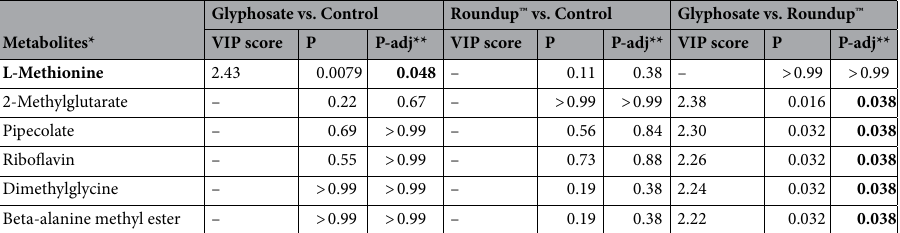
Table 1. The VIP score and fold change of metabolites significantly differentially measured between exposure groups in dams. * VIP score = Variable Importance in Projection scores obtained from PLS-DA analysis. Differences in mean values were assessed by two-sample Mann–Whitney test. Metabolites in bold were differential features confirmed by random forest feature selection method. **FDR-adjusted p values.